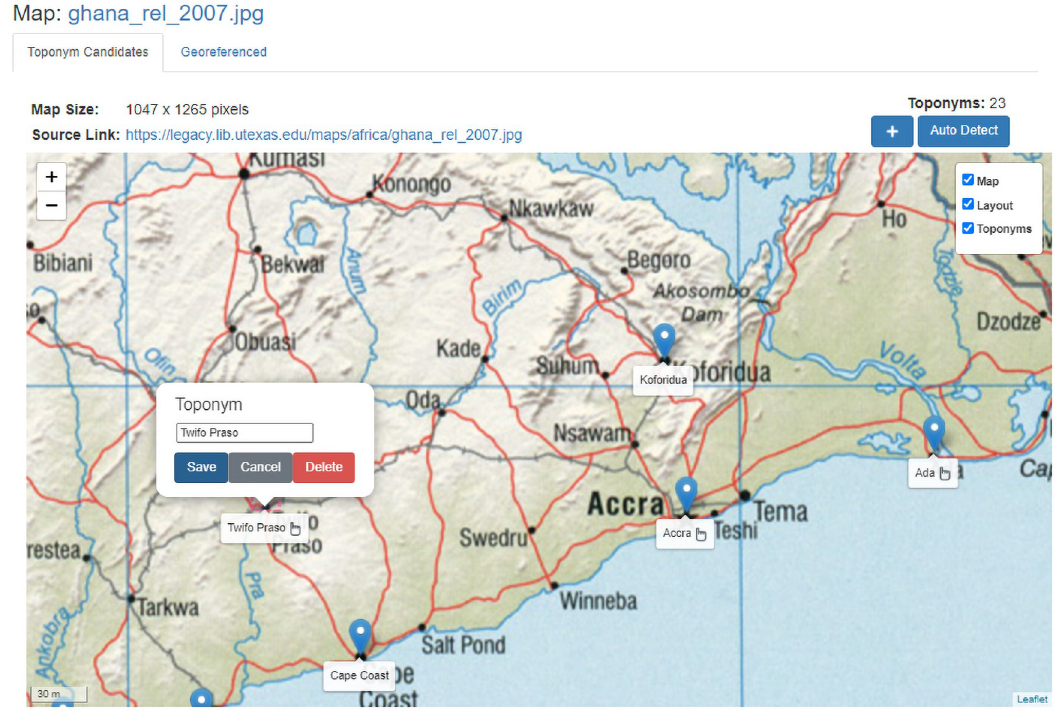
Fig 1. Example of a semi-automated workflow. Screenshot of a toponym-assisted georeferencing workflow. In a semi-automated workflow, if a user notices problems with toponym-based georeferencing, adjustments can be made through the manual selection and correction of control points. The map image is from the University of Texas at Austin’s Perry-Casta ñ eda Library (PCL) Map Collection and is in the public domain. https://doi.org/10.1371/journal.pone.0260039.g001 For the first stage (stage a), we implement a color thresholding approach to define some pixels as “text” and other pixels as “not text”. Contrasted to most existing implementations reliant on grayscale or RGB color thresholding [63–67], our implementation identifies per- ceived color similarities using the CIELab Delta E 2000 color difference metric 4 E [68]. Since most maps depict toponym labels in some shade of black or dark gray, for our automated approach we choose black as the reference color and isolate those pixels where the fuzzy color difference ( 4 E ) is smaller than 25 (see Fig 2a)—a hyperparameter that was determined through experimentation in order to capture color variation in edge pixels as well as color